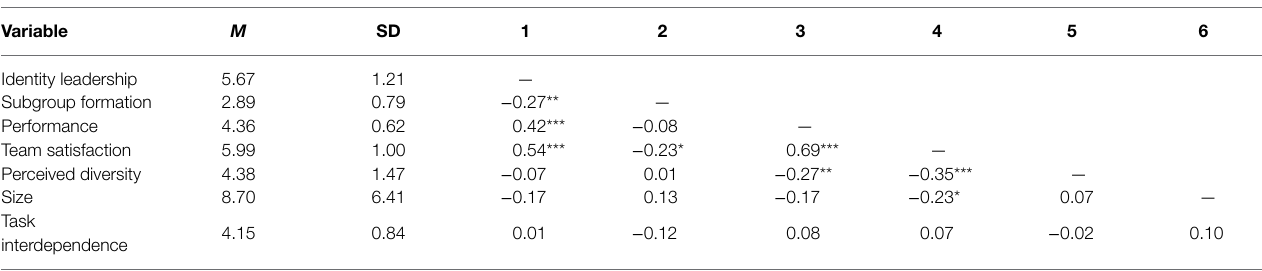
TABLE 1 | Mean, standard deviations, and Pearson-moment correlations of the study’s constructs ( N = 96). Variable M